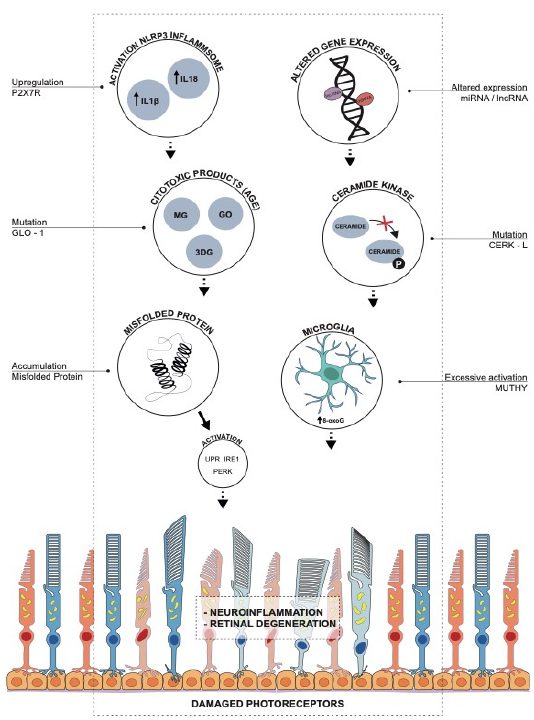
Figure 1. Main molecular mechanisms occurring during oxidative stress in RP.